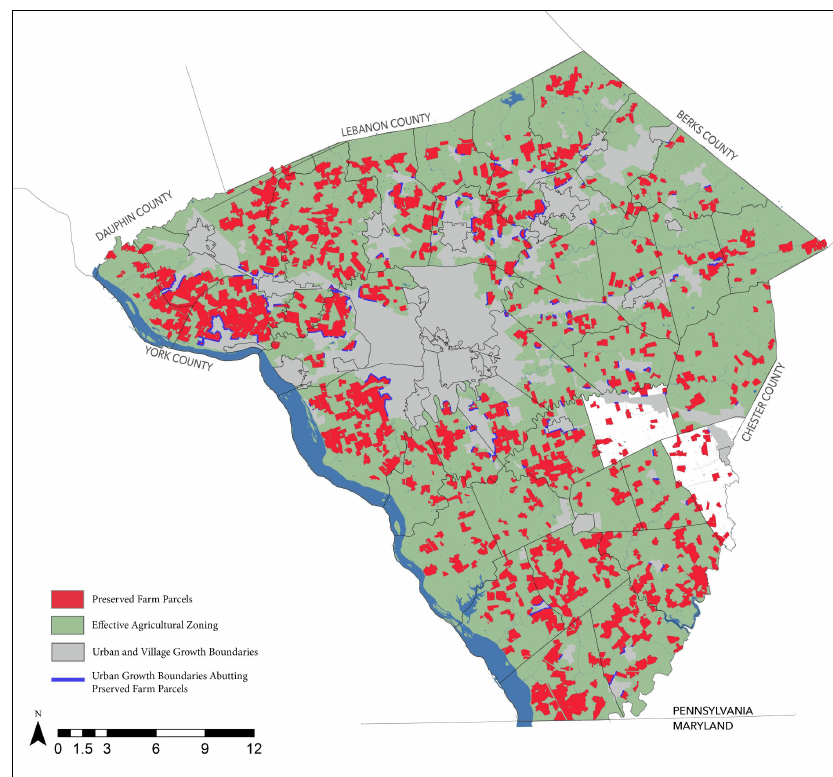
Figure 2. Preserved Farm Parcels, Urban Growth Areas, Effective Agricultural Zoning, and Preserved Farm Boundaries Touching Growth Boundaries, Lancaster County, Pennsylvania,